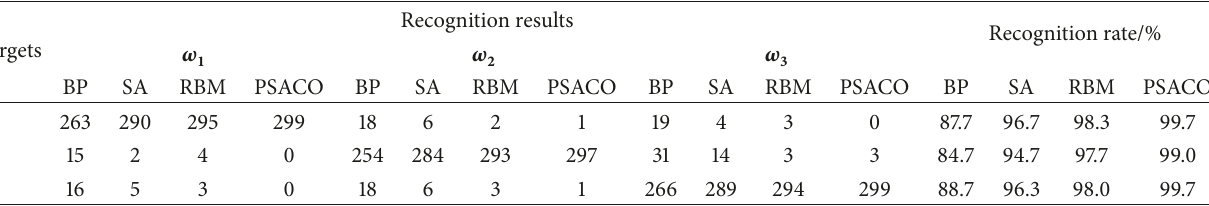
Table 8: Recognition results of CNIS-II for damaged